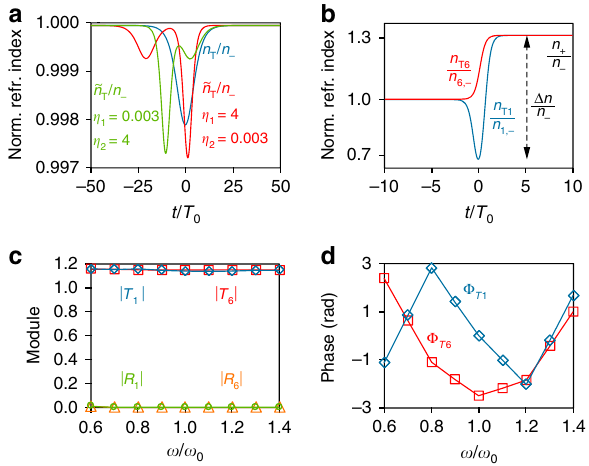
Fig. 3 T-SUSY re fl ectionless isospectral media and frequency